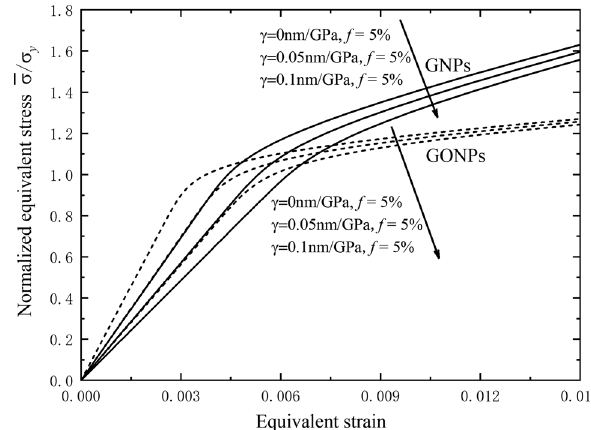
Figure 5: The relationship between the macroscopic Poisson ’ s ratio of the nanoplate composite with the fi ller volume fractions and interface sliding parameters.